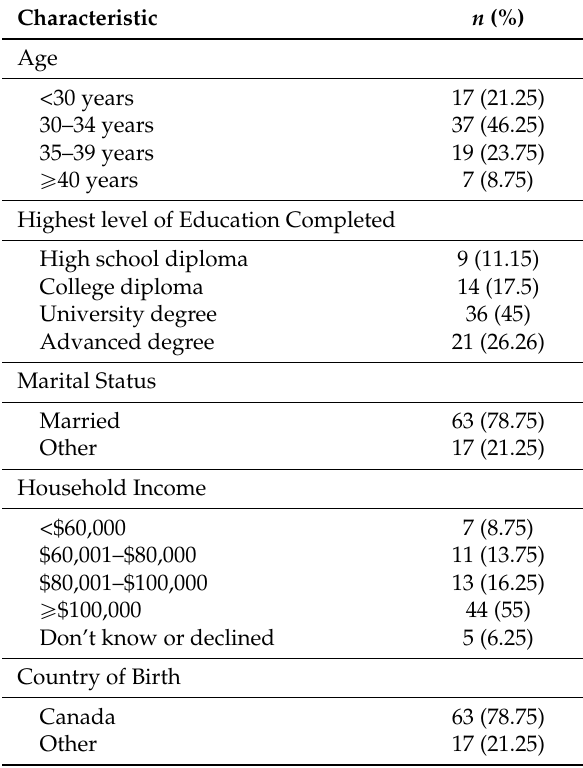
Table 2. Characteristics of study population ( n =